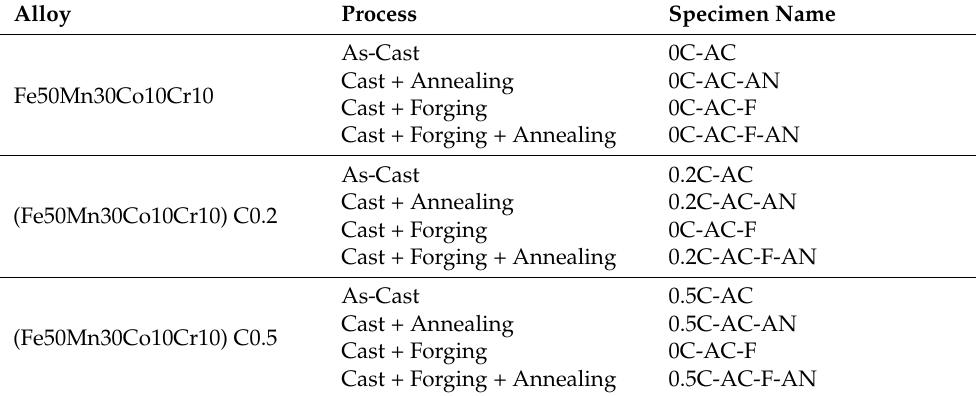
Table 3. Specimens and corresponding treatment processes (C wt.%). Alloy